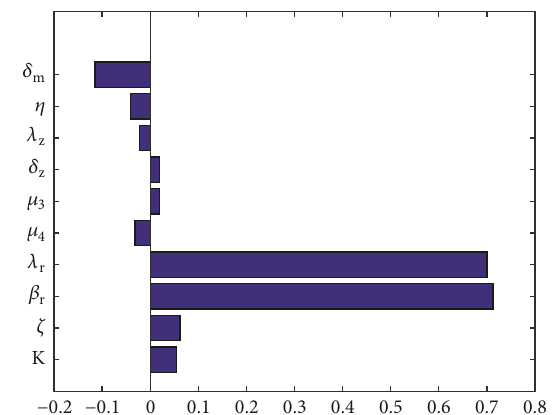
Figure 2: Tornado plots of PRCCs of parameters that influence model 𝑅 0 generated using parameter values in Table 3. Parameters with 𝑃𝑅𝐶𝐶 > 0 and 𝑃𝑅𝐶𝐶 < 0 increase and decrease model 𝑅 0 ,